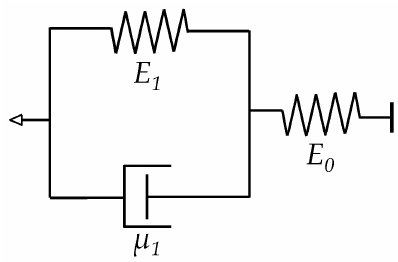
Figure 8. Rheological model for a Zener element.